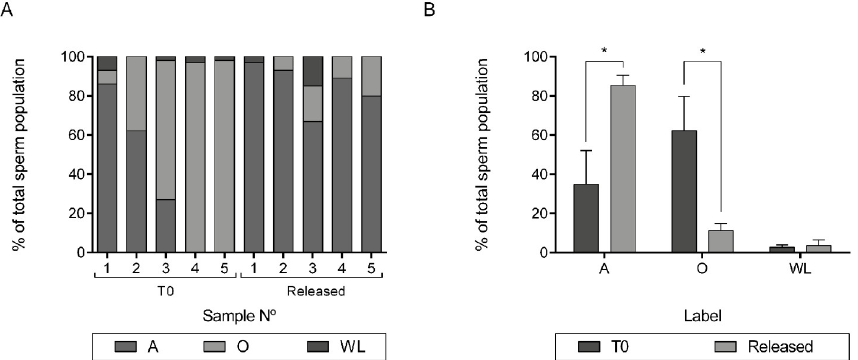
Fig 4. Sperm population released from BOEC. Integrin α 5 β 1 subcellular localization was assessed in sperm prior to co-culture (T0) and in sperm released from co-culture with BOEC (released). A) Percentage of sperm displaying integrin α 5 β 1 in the acrosomal region (A), other regions (O) and without label (WL). Results shown correspond to sperm from five independent samples (1–5). B) Mean of the percentages shown in panel A. Results are expressed as mean ± SEM. n = 5. � indicates p <